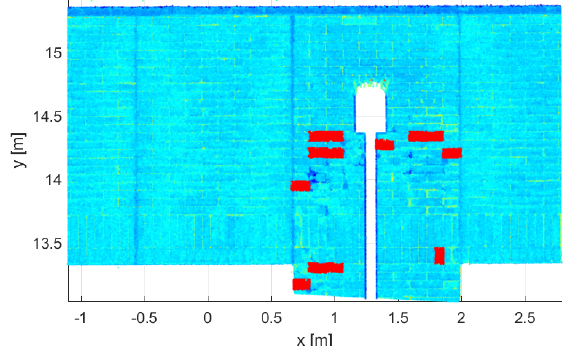
Figure 10. Misclassified bricks (red).